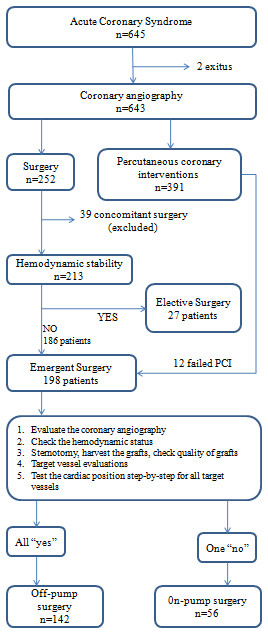
Patient Allocation Diagram.